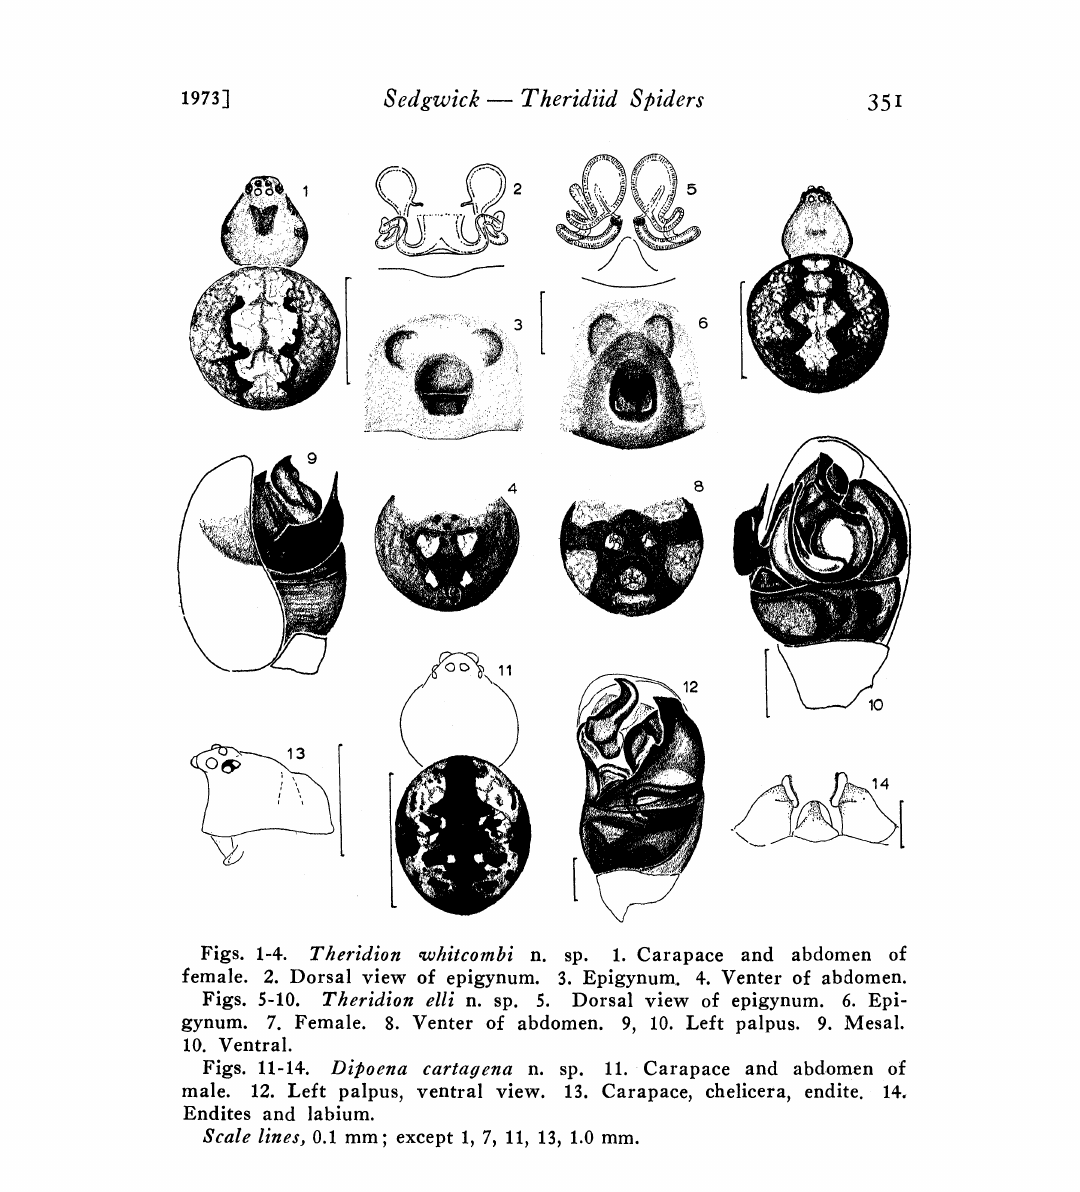
Figs. 1-4. Teridio hicombi n. sp. 1. Carapace and abdomen of female. 2. Dorsal view of epigynum. 3. Epigynum.. 4. Venter of abdomen. igs. 5-10. Teridio elli n. sp. 5. Dorsal view of epigynum. 6. Epi- gynum. 7. Female. 8. Venter of abdomen. 9, 10. Left palpus. 9. Mesal. 10. Ventral. Figs. 11-14. Dipoea cartagena n. sp. 11. Carapace and abd.on o male. 12. Left palpus, ventral view. 13. Carapace, ehelicera, endite. 14. Endites and labium. cale lies, 0.1 mm; except 1, 7, 11, 13, 1.0